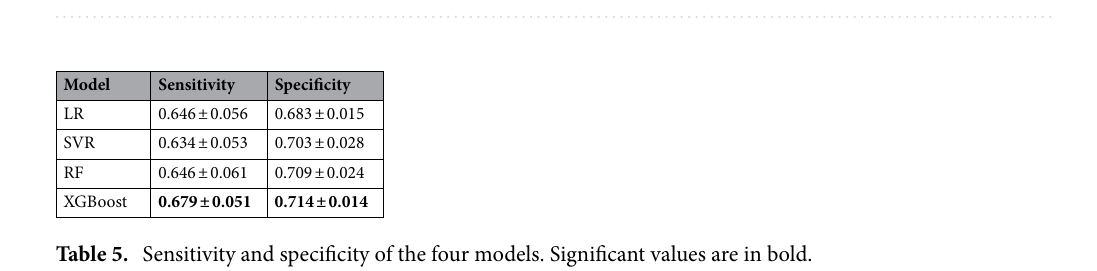
Table 4. Comparison of 10 features with significant statistical differences ( p < 0.01) between negative and positive groups.